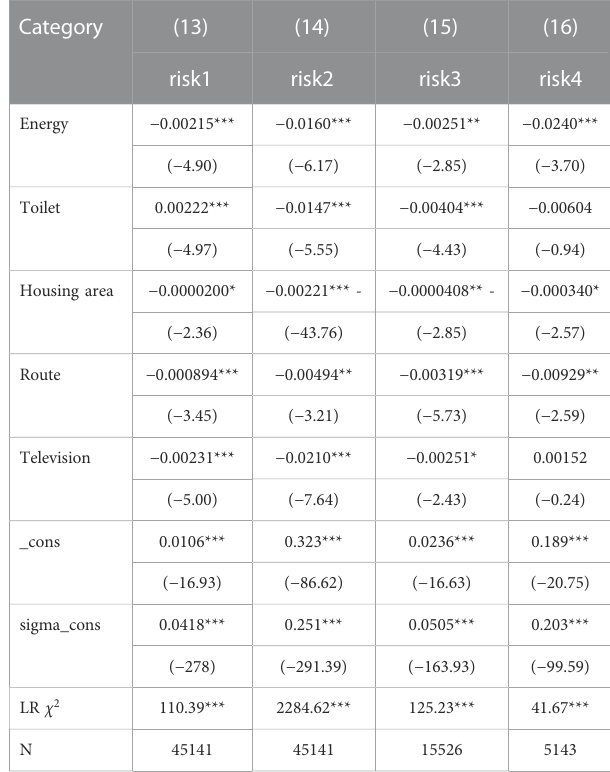
TABLE 7 Tobit regression estimates of physical capital variables to re-poverty